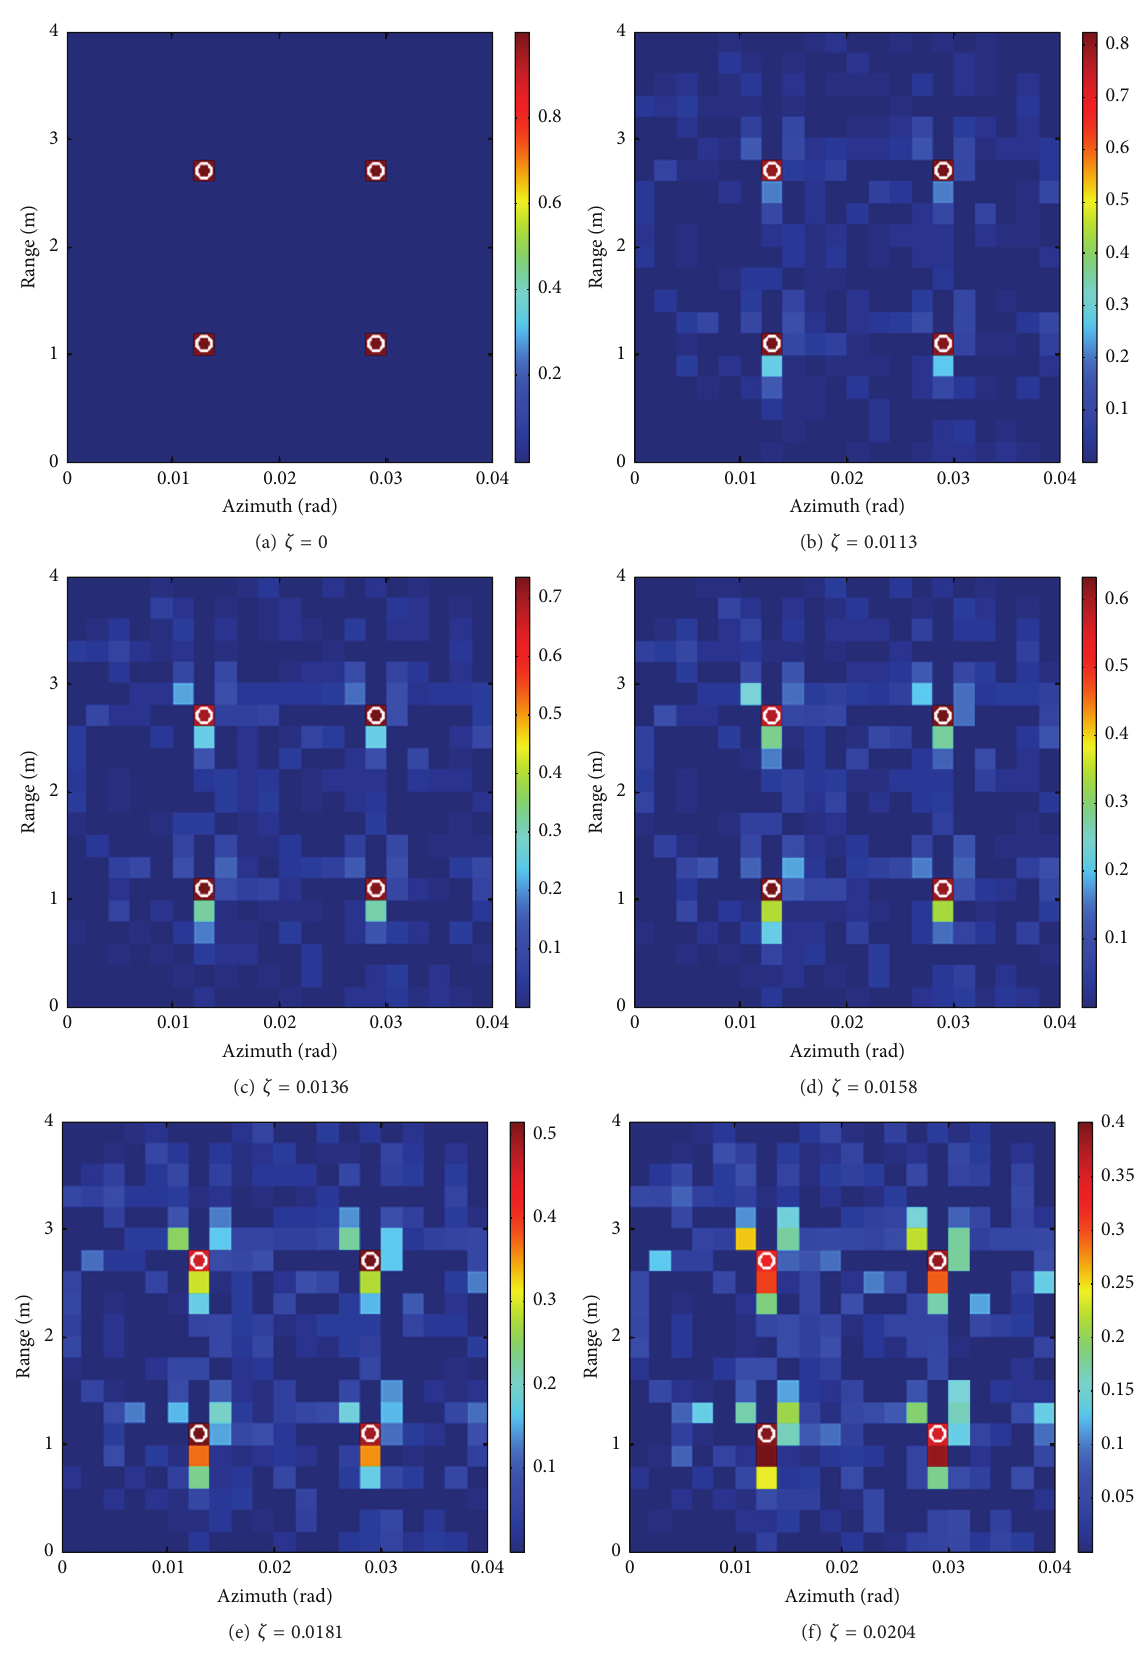
Figure 2: RCI results when 𝜁 = {0,0.0113, 0.0136, 0.0158, 0.0181, 0.0204}